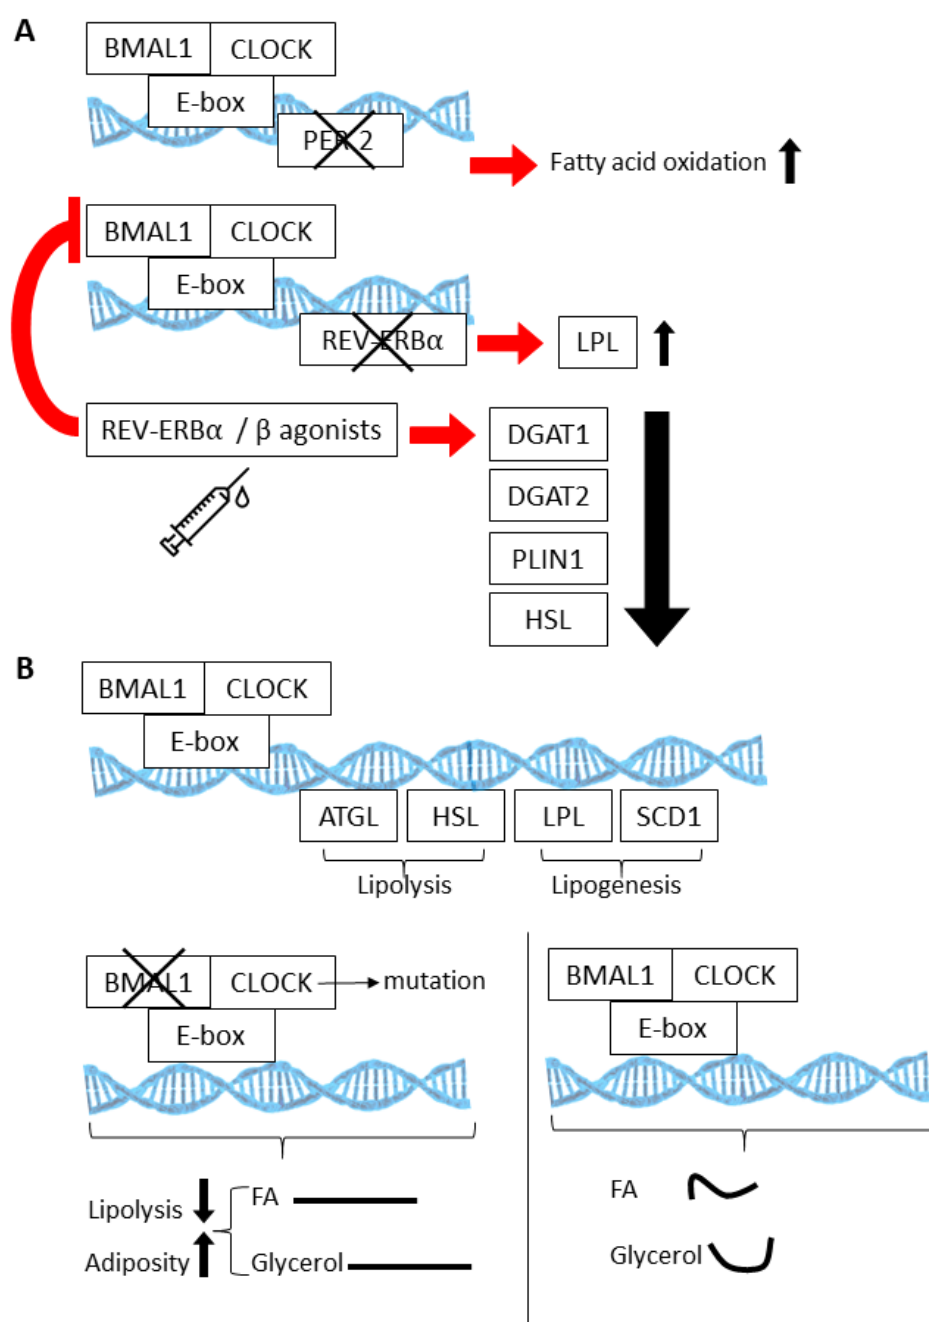
Figure 2. The BMAL1:CLOCK (Aryl Hydrocarbon Receptor Nuclear Translocator Like (AHRNTL aka BMAL):(Circadian Locomotor Output Cycles Protein Kaput)) heterodimer regulates multiple genes involved in fatty acid oxidation ( A ), lipogenesis, and lipolysis ( B ). Knockout models involving loss of the circadian proteins PER2, REV-ERBA, and BMAL1 have elucidated the physiological consequences of these activities within the context of white adipose tissue (WAT) and brown adipose tissue (BAT) (also see Table 1). (Curved lines are indicative of rhythmic